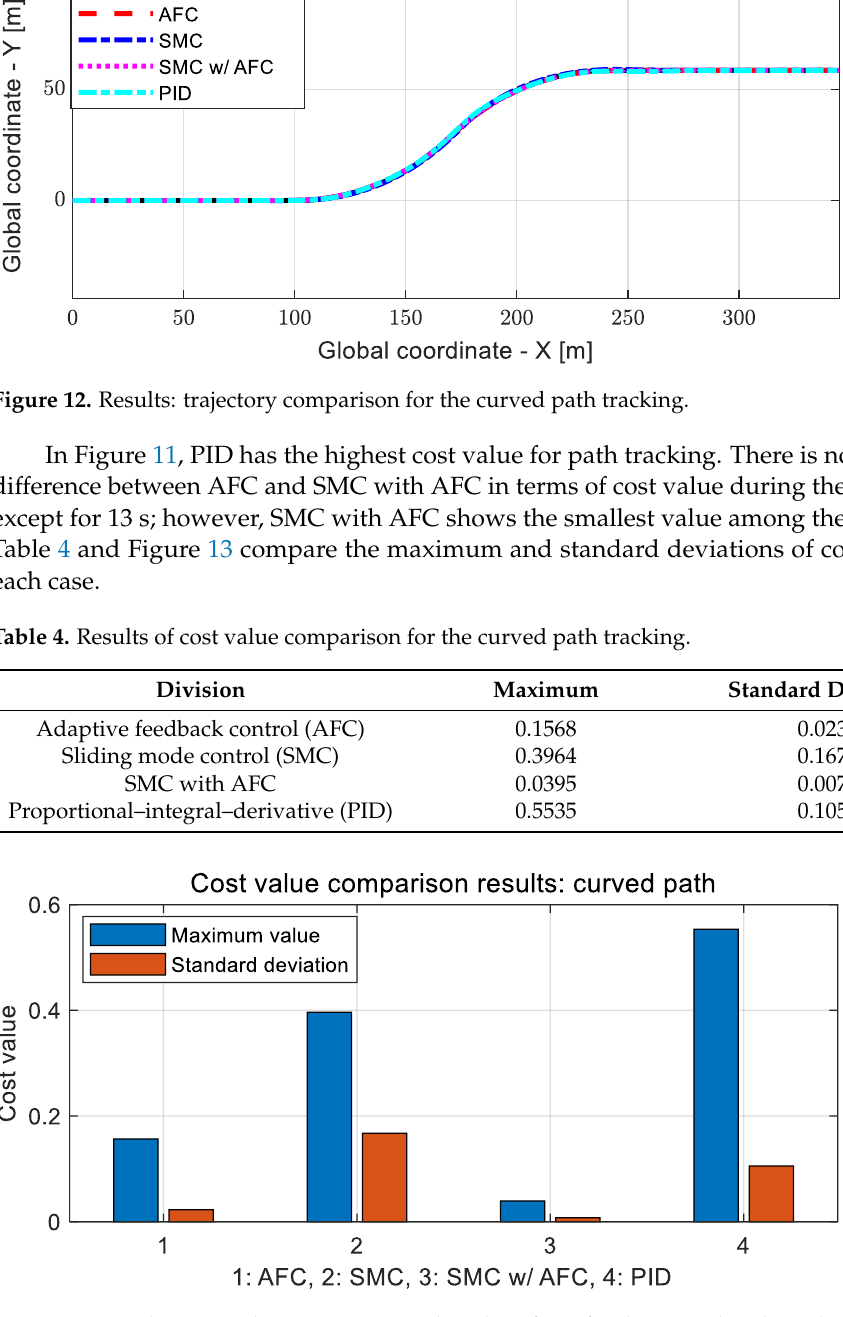
Figure 11. Results: cost value comparison for the curved path tracking.